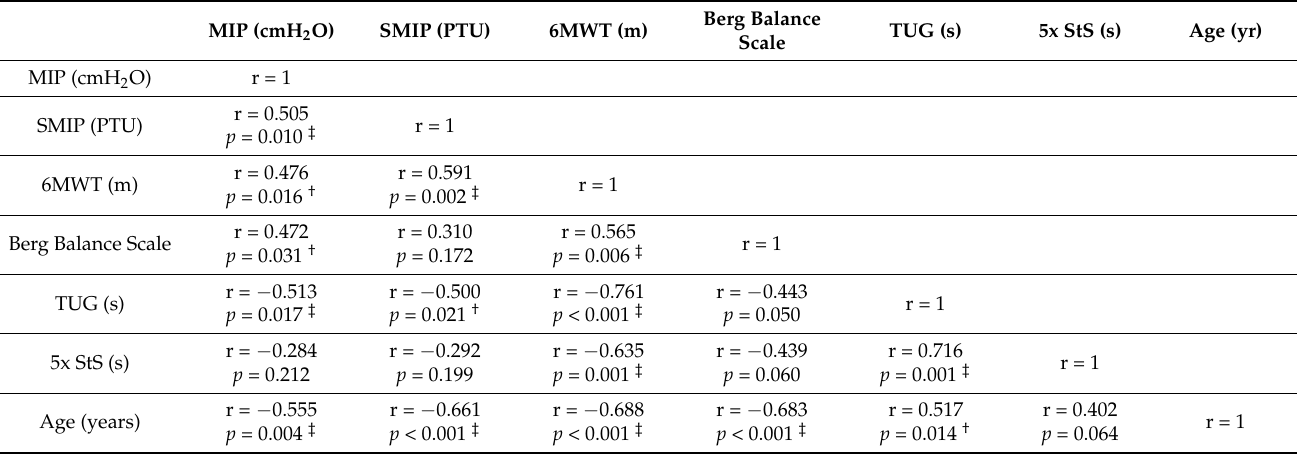
Table 3. Spearman’s Rho correlation coefficients among key outcome measures.